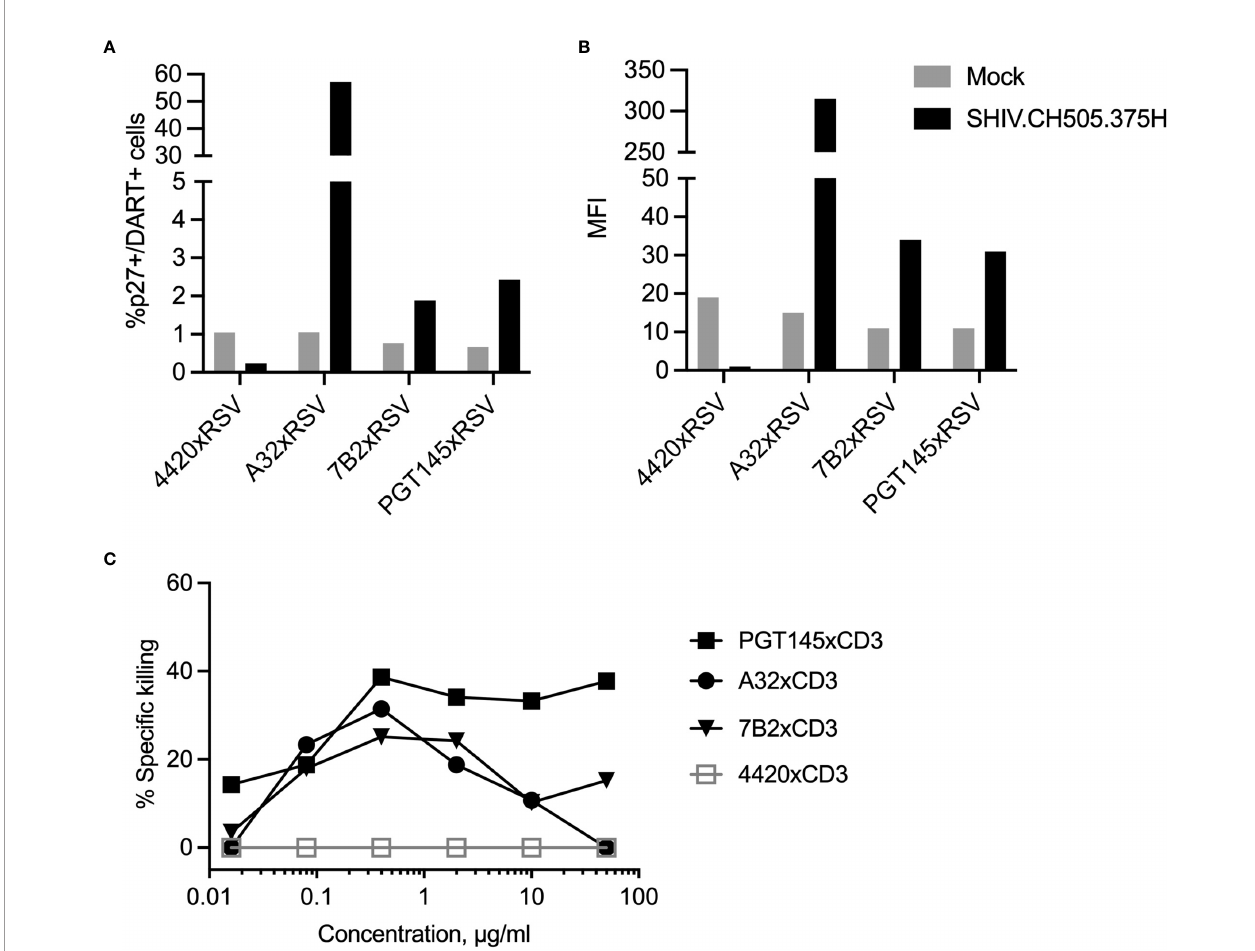
FIGURE 1 | DART molecule binding to SHIV-infected A66 cells and their redirected killing in the presence of human CD8 T cells. The binding of HIVxRSV DART molecules with A32, 7B2 or PGT145 anti-HIV-1 Env speci fi cities to SHIV.CH505.375H-infected A66 cells was evaluated to determine (A) frequency of SHIV-infected cells bound by DART molecules (%p27+/DART+) and (B) median fl uorescent intensity (MFI). The 4420 DART molecule, which contains an anti- fl uorescein speci fi city instead of an anti-HIV-1 Env speci fi city, was used as the negative control. (C) Titration curves represent DART-mediated killing of SHIV.CH505.375H-infected A66 cells as targets (T) by human CD8+ T cells as effectors (E) with E:T ratio of 33:1. The % Speci fi c killing was determined 6 hours post by incubation of T+E+DART molecules measuring the reduction in the percentage of p27+ cells in presence of DART molecules compared to T+E